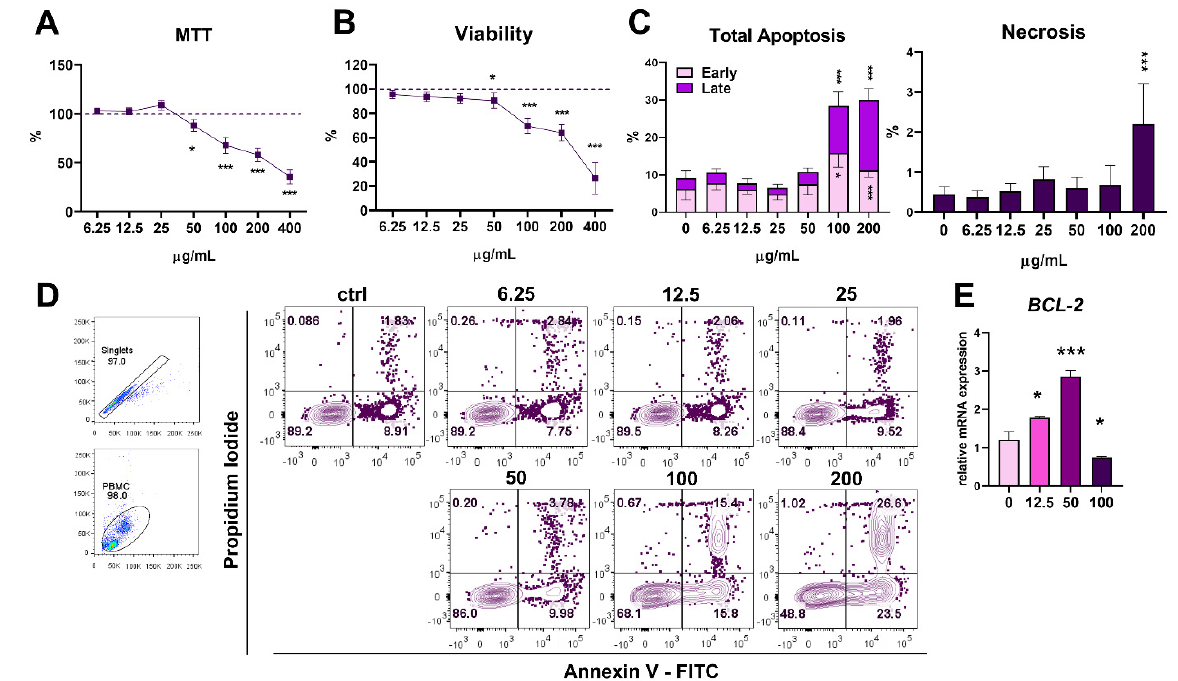
Figure 2. Cytotoxicity of PoPEx in culture with PBMC. Cytotoxicity of PBMC was determined in the culture of PBMC (3 × 10 5 /well) treated with increasing doses of PoPEx (6.25–400 µg/mL) for 24h, followed by the analysis of ( A ) relative metabolic activity by MTT assay; ( B ) relative viability, as determined by Trypan blue exclusion assay; ( C ) The summarized data on the percentage of apop- totic cells (Annexin-V+ PI- for early apoptotic cells; Annexin-V + PI+ for late apoptotic cells)